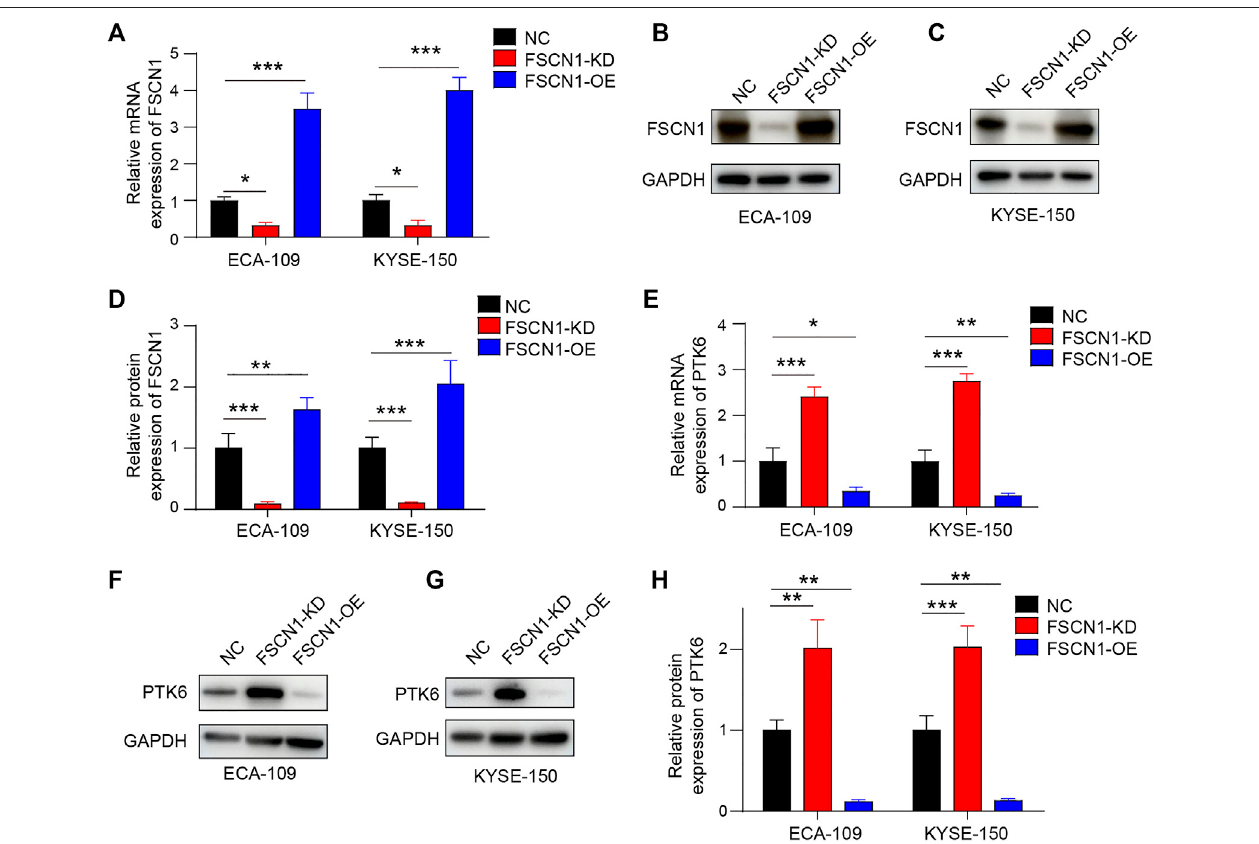
FIGURE 2 | FSCN1 downregulates PTK6 expression in ESCC cell lines. (A – D) Lentivirus containing FSCN1 shRNA sequence (FSCN1-KD) and over-expressed sequence (FSCN1-OE) were added into ECA-109 and KYSE-150 mediums separately. Lentivirus expressingGFP only was used asa negative control (NC). The mRNA (A) andprotein level (B – D) ofFSCN1inthe2 cell linesweredetected. n =3per group, ** p < 0.01,*** p < 0.001. (E – H) ECA-109and KYSE-150 infected byNC,FSCN1- KD, and FSCN1-OE as indicated were harvested, and the mRNA (E) and protein level (F – H) of PTK6 in the 2 cell lines were detected. n = 3 per group, * p < 0.05, ** p < 0.01, *** p <